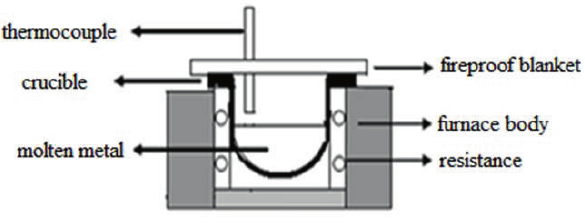
Figure 3. Schematic representation of melting